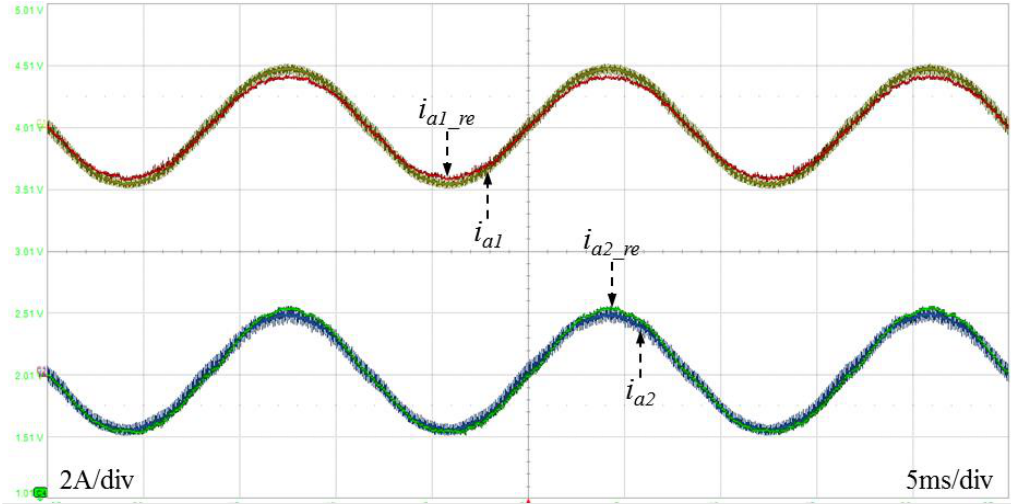
Figure 8. The actual current and reconstructed currents in phase A.